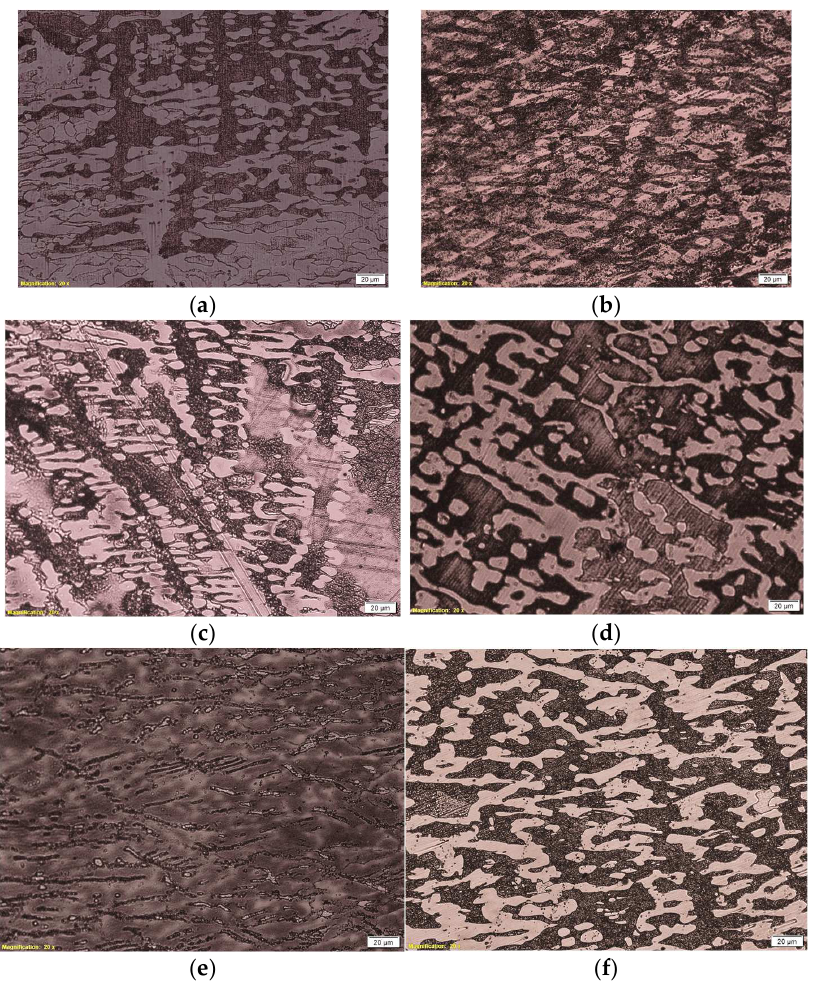
Figure 8. Optical micrographs of deformed Fe-30.9Mn-4.9Al-4.5Cr-0.4C under different deformation conditions: ( a ) 800 °C at 0.1 s −1 ; ( b ) 800 °C at 5 s −1 ; ( c ) 900 °C at 0.1 s −1 ; ( d ) 900 °C at 5 s −1 ; ( e ) 1000 °C at 0.1 s −1 ; ( f ) 1000 °C at 5 s −1 .